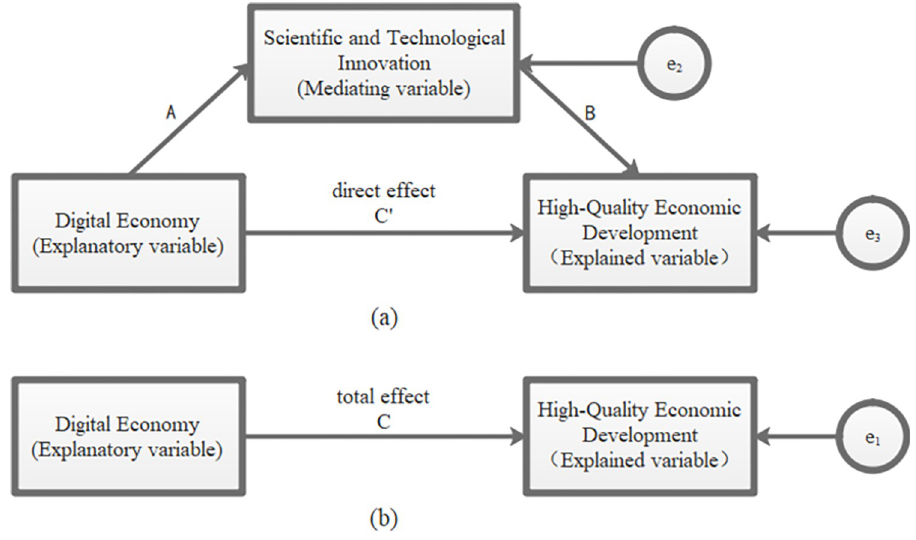
Fig 4. Mediating effect model